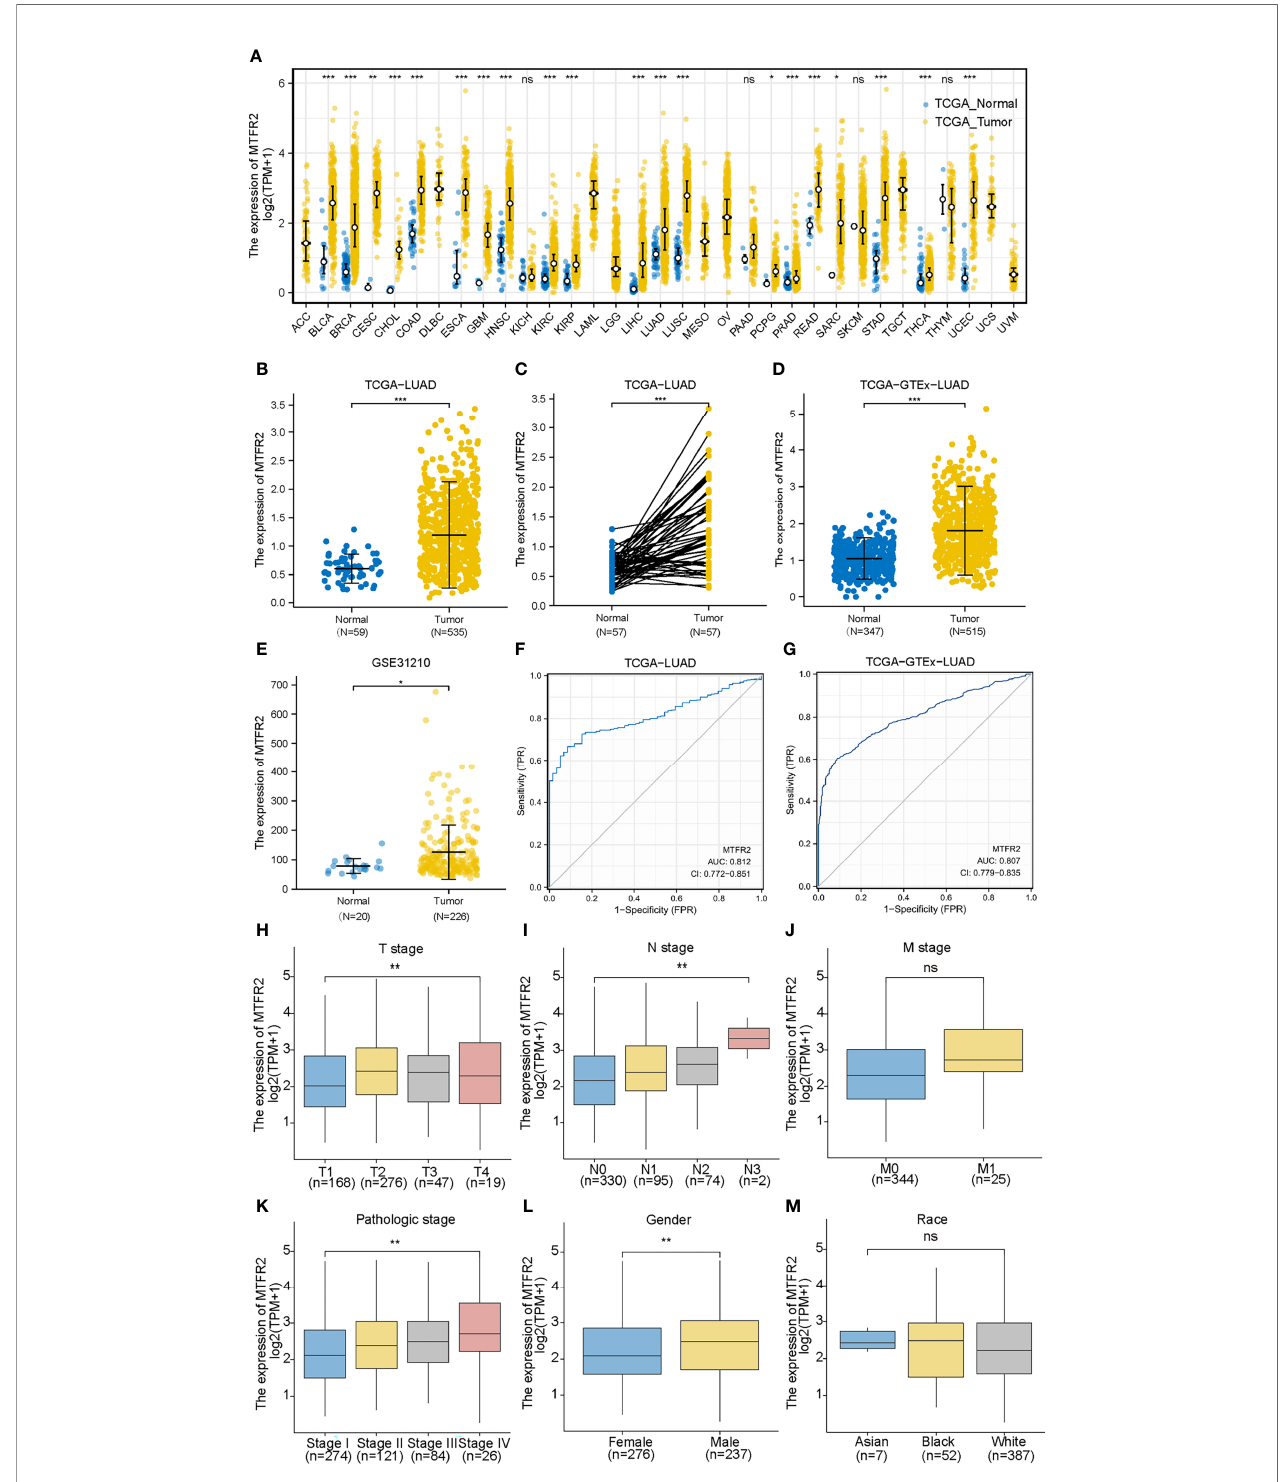
FIGURE 1 | MTFR2 was highly expressed in LUAD tissues based on bioinformatical analysis. MTFR2 was overexpressed in pan-TCGA cancer (A) , TCGA-LUAD (B) , TCGA-LUAD paired samples (C) , TCGA-GTEx-LUAD (D) , and GSE31210 dataset (E) . ROC indicated that MTFR2 predicted the poor prognosis in TCGA and TCGA +GTEx data sets and AUC was 0.812 and 0.807 separately (F, G) . MTFR2 expression associated with clinic-pathological features: T stage (H) , N stage (I) , pathological stage (K) , and gender (L) but not signi fi cantly with M stage (J) and race (M) . LUAD, lung adenocarcinoma; ROC, received operation curve. * P < 0.05, ** P < 0.01, *** P < 0.001, ns, no statistical signi fi